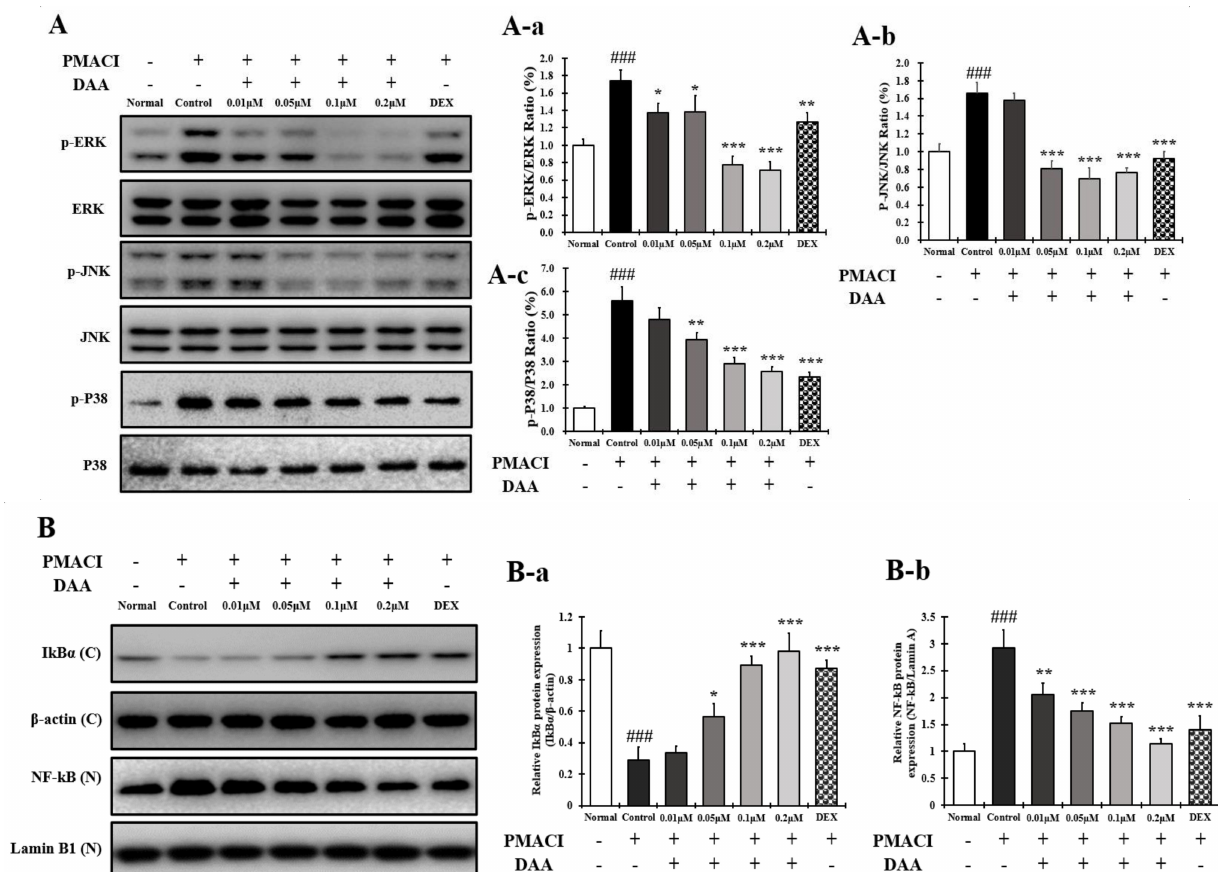
Figure 13. Effect of DAA on MAPK phosphorylation and NF-kB activation in HMC-1 cells. ( A ) DAA inhibited the phosphorylation of MAPK (ERK, JNK, and P38) in HMC-1 cells ( A-a – A-c ). ( B ) DAA also inhibited the degradation of IkB α and the translocation of NF-kB into the nucleus ( B-a , B-b ). I κ B α was normalized to β -actin and NF-kB was normalized to Lamin B1. The results are expressed as the mean ± SD (n = 4). ### p < 0.001 vs. normal; * p < 0.05, ** p < 0.01, and *** p < 0.001 vs. control; DAA was used at 0.01 µ M, 0.05 µ M, 0.1 µ M, and 0.2 µ M. DEX, the positive control, was used at 0.1 µ